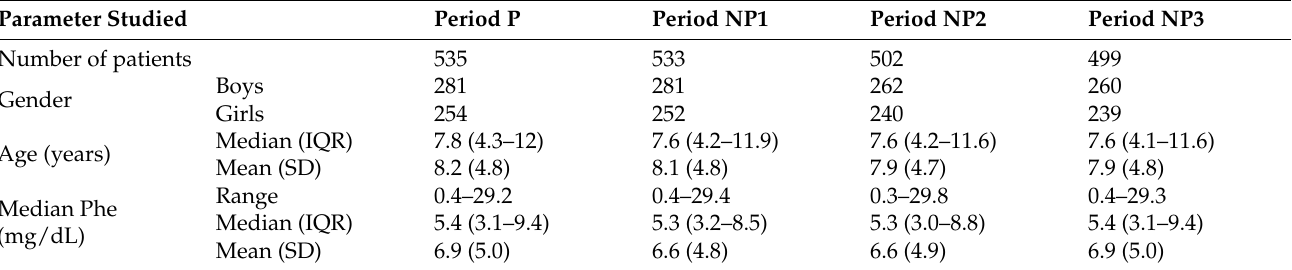
Table 1. Basic characteristics of the studied patients with phenylketonuria.